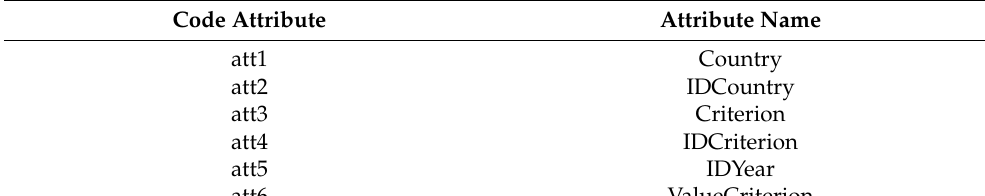
Table 2. Annual total population: attributes of the time series.